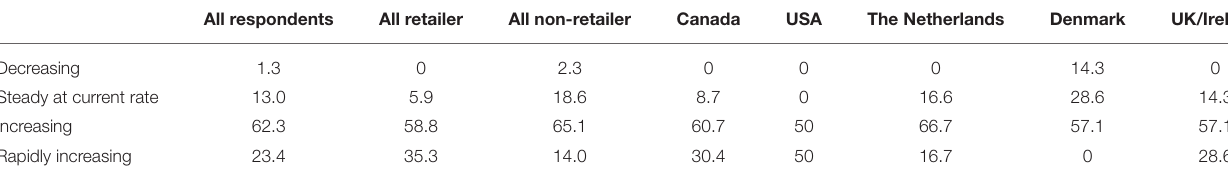
TABLE 5 | Respondent opinions regarding the future adoption of AMS from 2011 to 2015, presented as